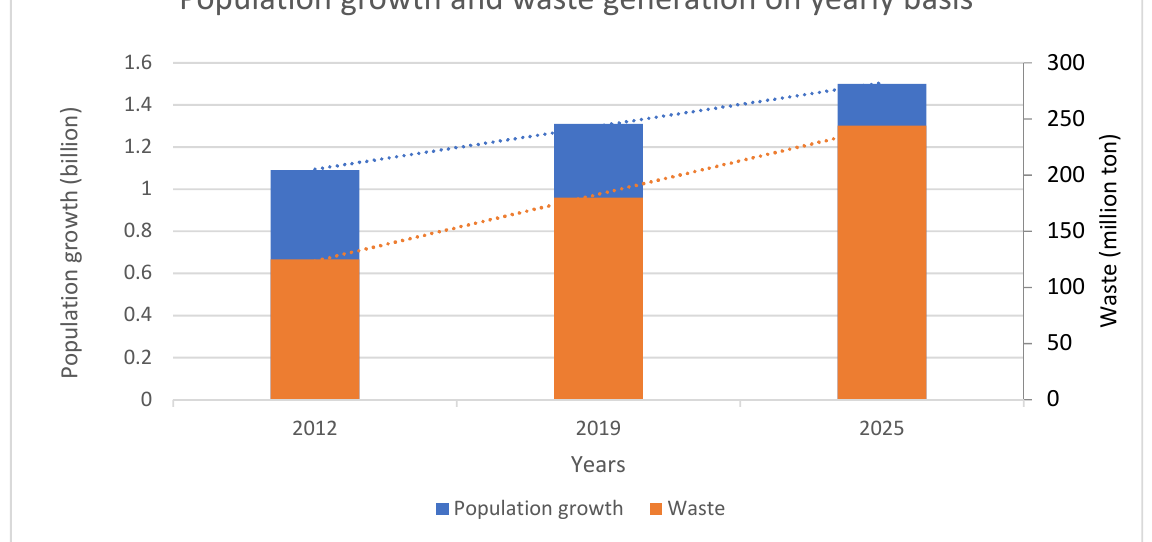
Figure 1. Anticipated trend of population growth and waste generation from 2012 to 2025 within SSA, data from Tieso [8], Scarlat et al. [9], Tabutin [10], United Nations [11] and Ayeleru et al. [12].